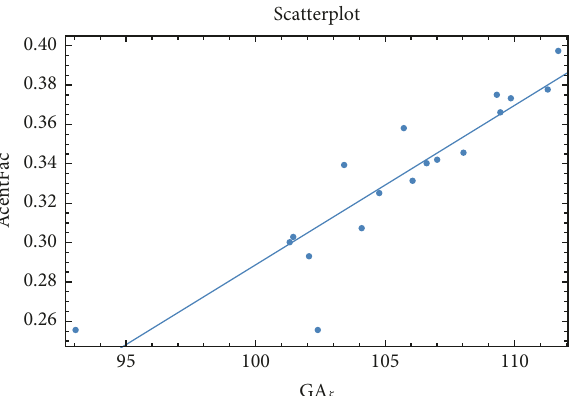
Figure 16: Plot for the residuals of AcentFac on KB ξ